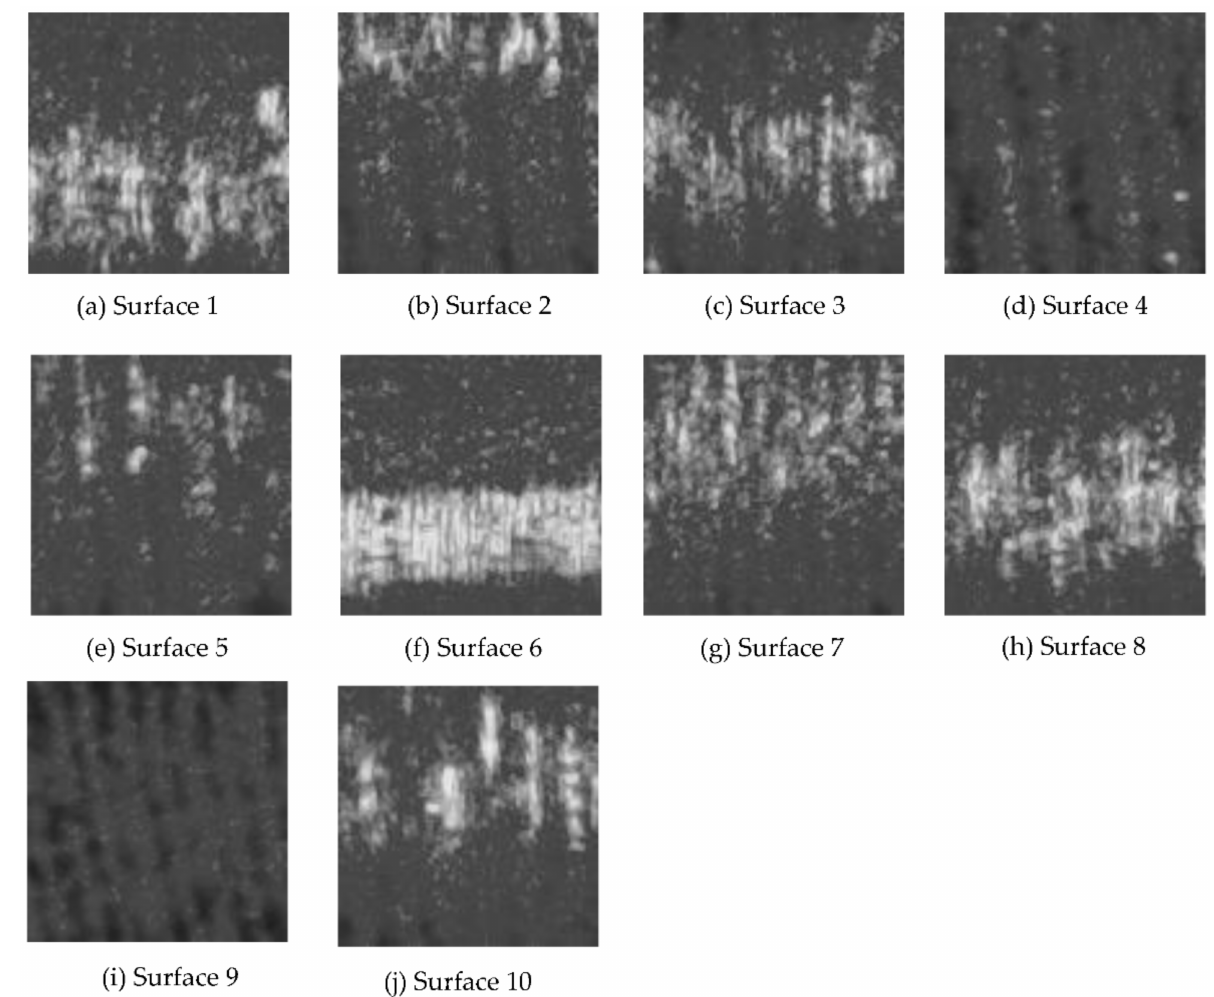
Figure 6. ( a – j ) are the grayscale images of the laser speckle pattern images for each surface at illumination angle of 45 ◦ , f number of 16 and shutter speed of 1/100 s.